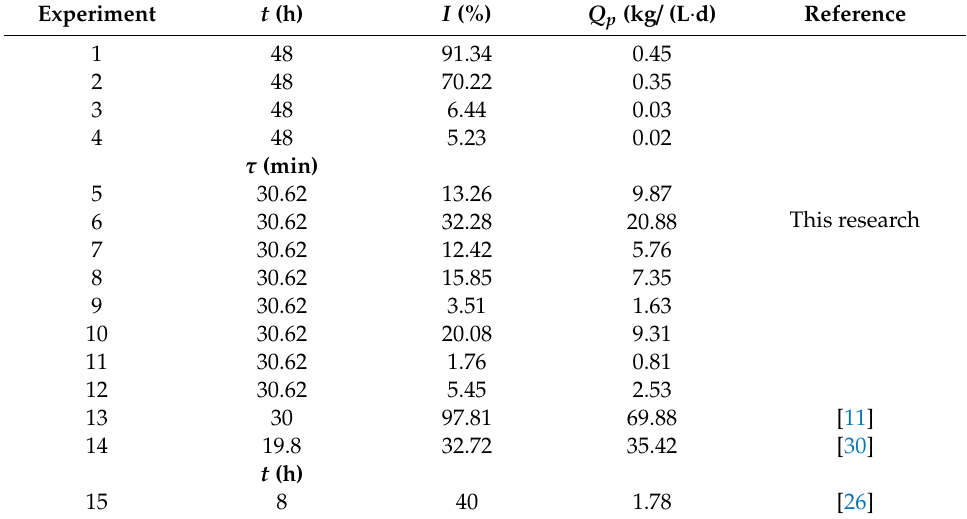
Table 4. Comparison of the oil transesterification process performed in a batch and in di ff erent types of